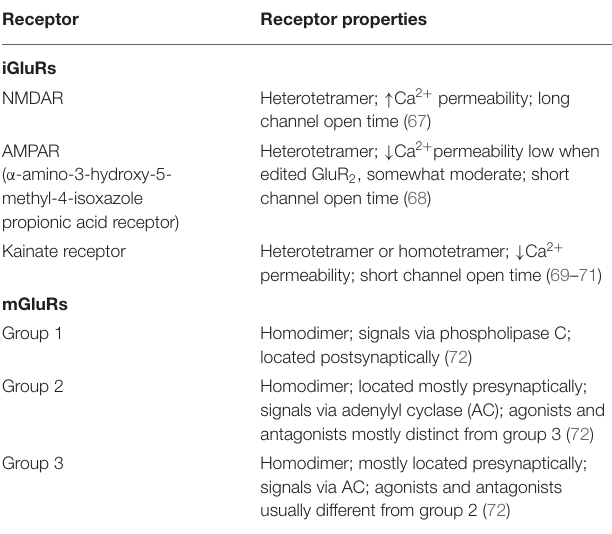
TABLE 2 | Glutamate receptor protein subunit composition and properties.